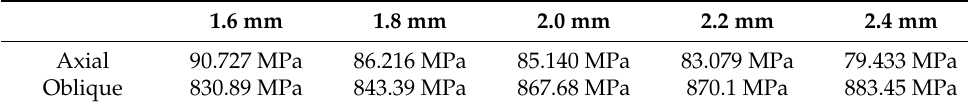
Figure 16. Cortical bone von Mises stress. Table 8. Cortical bone von Mises stress